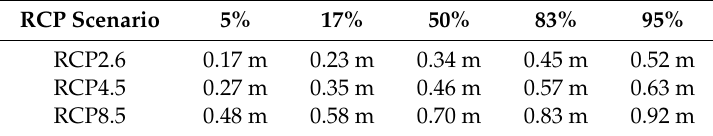
Figure 4. Global probabilistic sea-level projections obtained in this study (2100, with respect to a 1986–2005 average; unit: m). Table 4. Global mean sea-level rise projections by 2100 relative to 1986–2005 (“Dep” case).